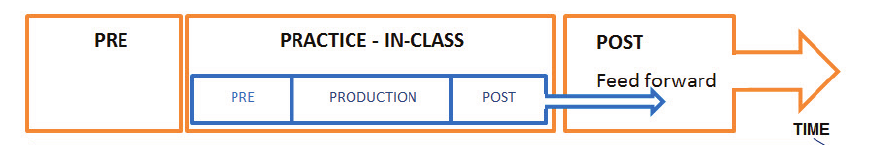
Figure 3: In a schematic form, illustration of the chronological relationship between teacher and students as learning designers regarding the work. Orange = teacher; blue = students